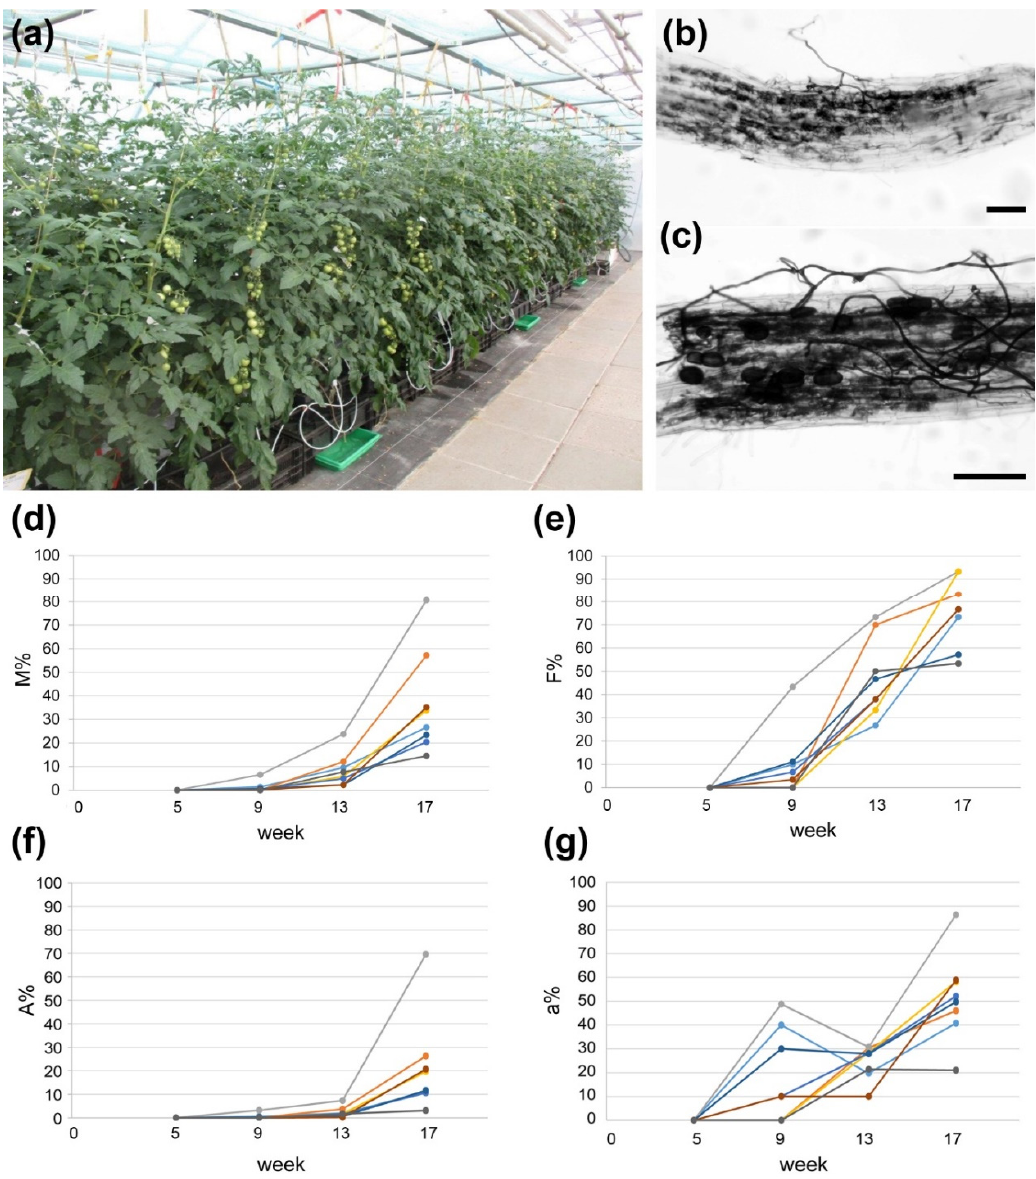
Figure 2. Mycorrhization of tomato plants (cv. Picolino/Maxifour) under producer-like conditions. ( a ) Cultivation set-up at INOQ GmbH (August 2019) using “Hawita special mix” as substrate and fertilization with 180 µM P 2 O 5 (YaraTera/White fertilizer). ( b , c ) Ink-stained roots from mycorrhizal plants at the end of cultivation period showing fungal hyphae and arbuscules. Bars represent 100 µm. ( d ) Development of AM intensity (M%), ( e ) AM frequency (F%) and ( f ) arbuscule frequency (A%) in the root systems of eight single plants inoculated with R. irregularis . ( g ) Development of arbuscule abundance in mycorrhizal parts of root fragments (a%) of eight single plants inoculated with R. irregularis . For ( d – g ) time is given as weeks after inoculation.